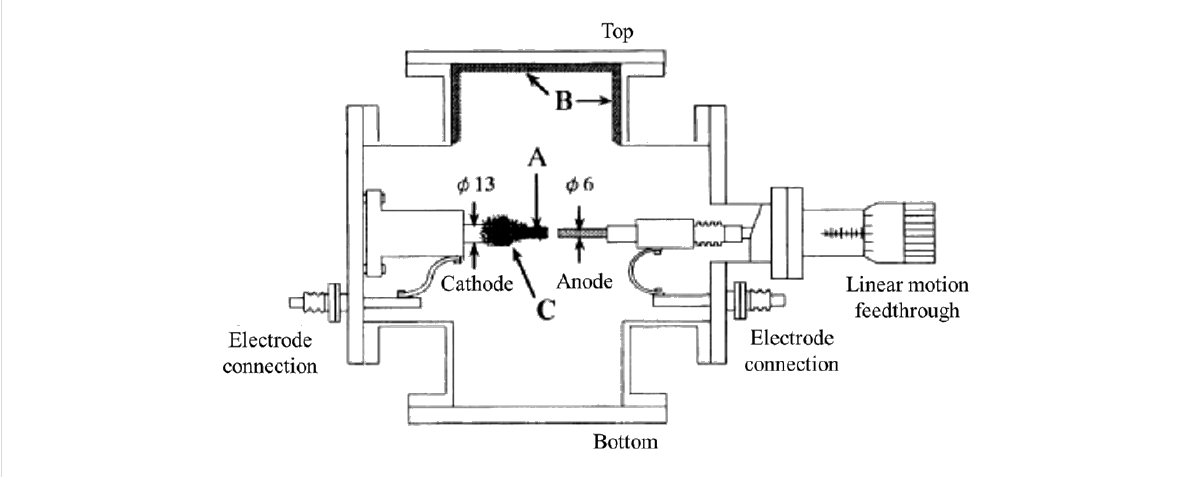
Figure 14: Schematic diagram of an arc evaporator (horizontal arrangement of electrodes). (A) carbonaceous hard deposit grown on the end of the cathode called “cylindrical hard deposit”, (B) soot grown on surface of the cathode is “chamber soot”, (C) soot deposited on the ceiling of the evapo- rator is “cathode soot”. Reproduced with permission from [128], copyright 2000 Elsevier.